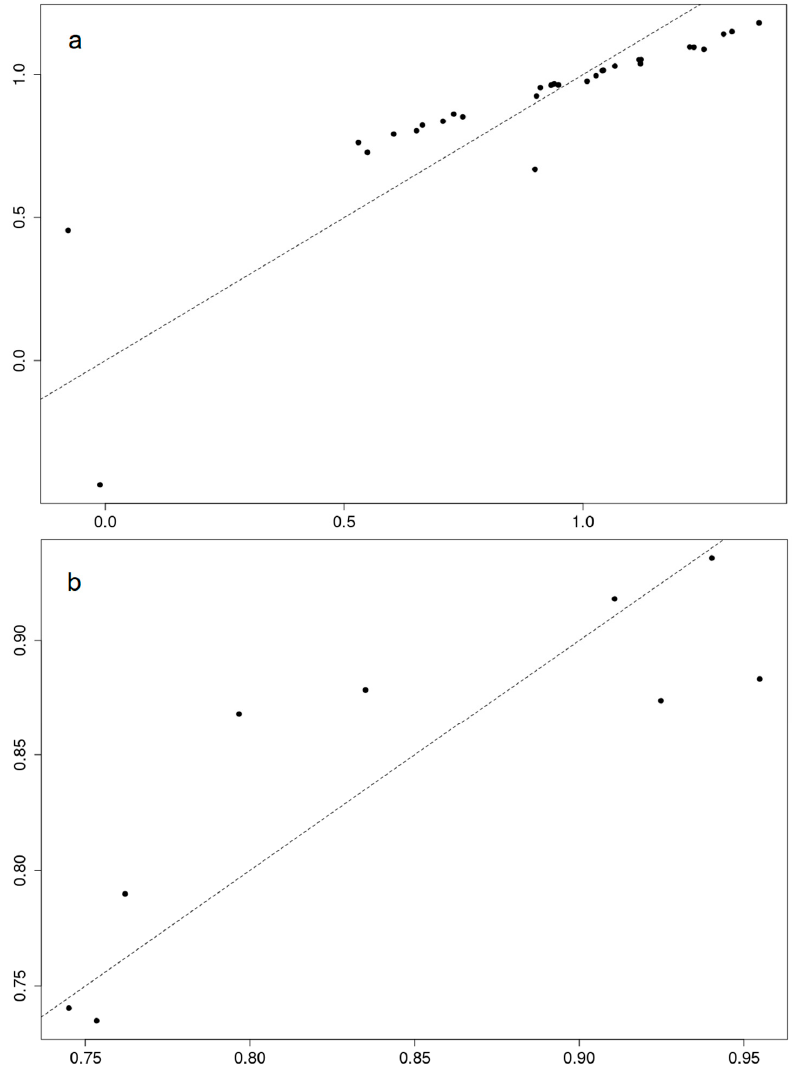
Figure 12. Comparison between observed values (dots) against adjusted values (line) of the linear regression for ( a ) PC1 and ( b ) PC2.